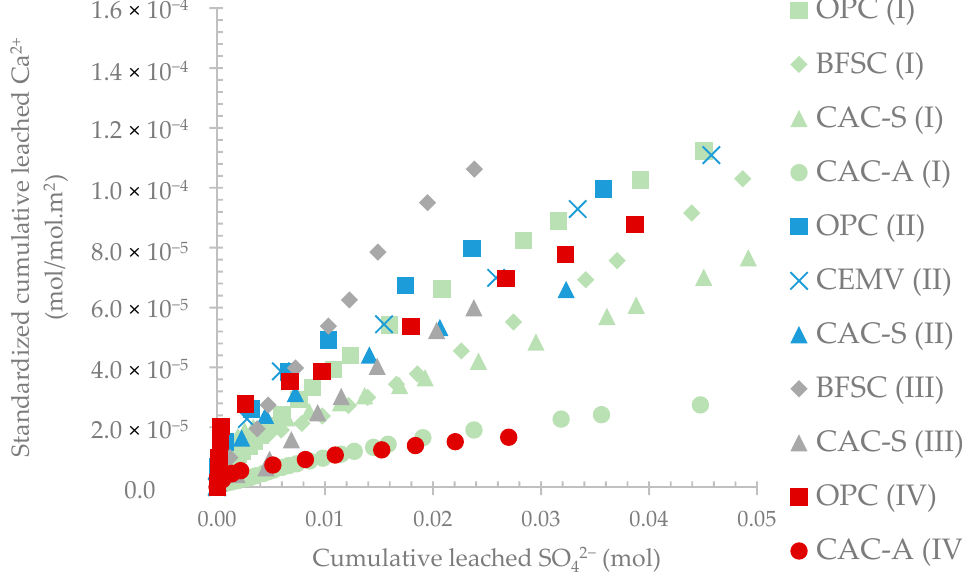
Figure 8. Cumulative leached sulfate from different testing campaign using the BAC test.